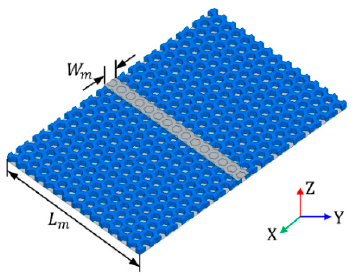
Figure 2. Microstrip line on the honeycomb substrate with microstrip line width, W m = 3.85 mm and honeycomb substrate length, L m = 45 mm.